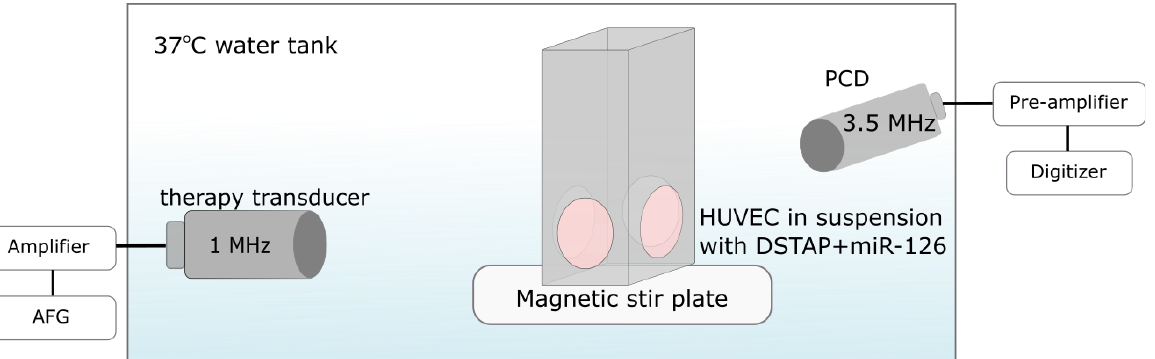
Figure 1. Experimental setup equipped with two co-aligned transducers for ultrasound-mediated gene delivery to endothelial cells . The therapy transducer (1 MHz) focuses within a cell suspension chamber, while the second transducer (3.5 MHz) is used for passive detection of bubble echoes. Following ultrasound treatment, the cells were transferred from the custom-designed suspension chamber to a conical tube left at room temperature for 5 min to allow for sonoporation recovery. These cells were then placed on ice until all the samples were treated before washing three times at 220 × g for 5 min at 4 ◦ C per wash to remove the remaining bubbles. The sham controls were handled similarly without